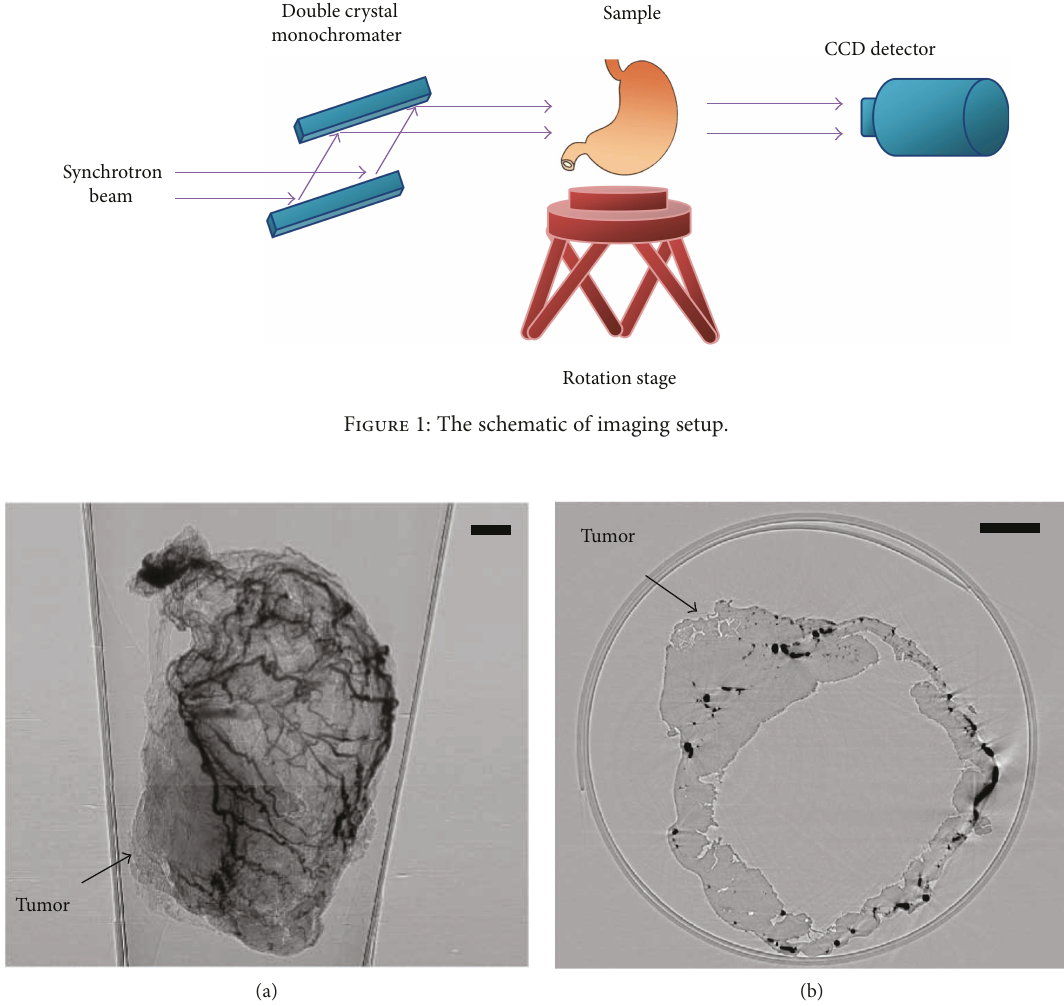
Figure 2: The projection and CT reconstruction images of PC-CT. (a) One projection image; (b) one CT slice (bar: 1mm).